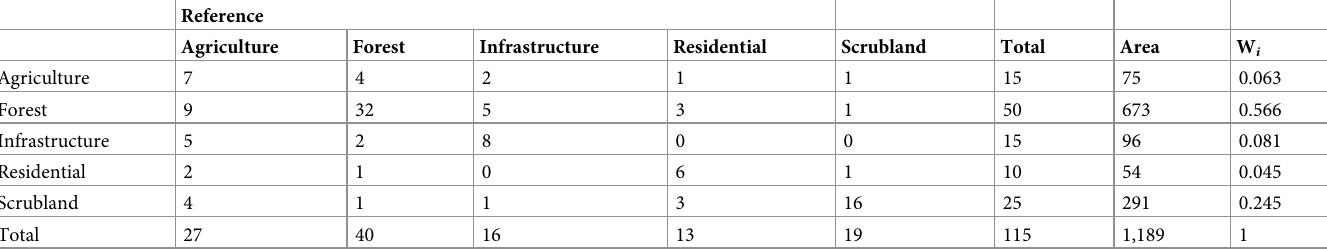
Table 5. Error matrix (sample count) for 2012 based on stratified random sampling.